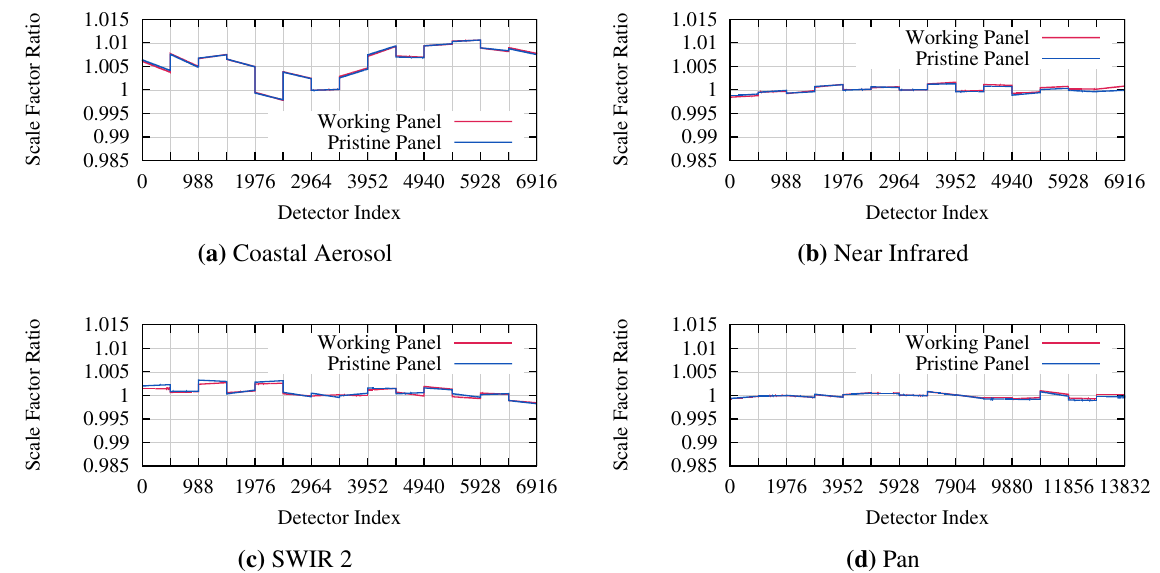
Figure 6. Apparent changes in the diffuser nonuniformity between pre-launch heliostat measurements and on-orbit measurements for both diffuser panels. ( a ) Coastal Aerosol. ( b ) Near Infrared. ( c ) SWIR 2. ( d ) Pan.